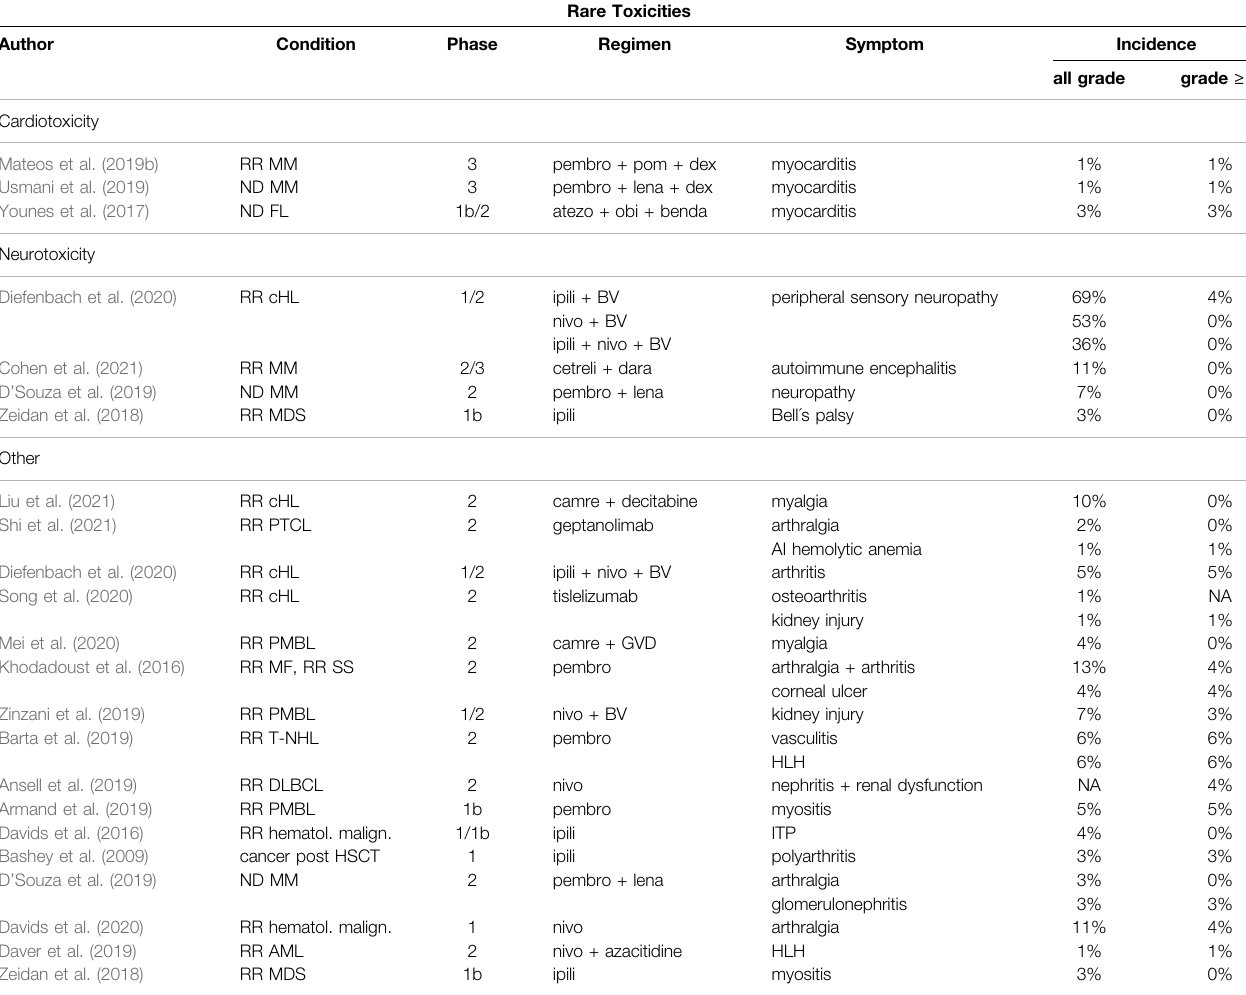
TABLE 6 | Incidence of rare irAEs in hematological